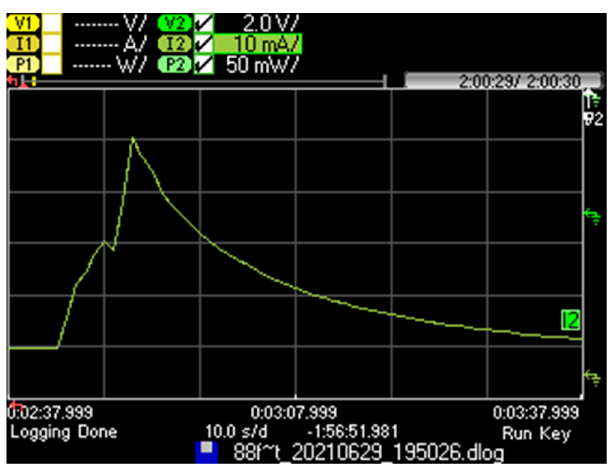
Figure 4. Current consumption pattern of a RockBLOCK Mk2 device that is initially in sleep state, performs a successful message transmission, and returns to sleep state.